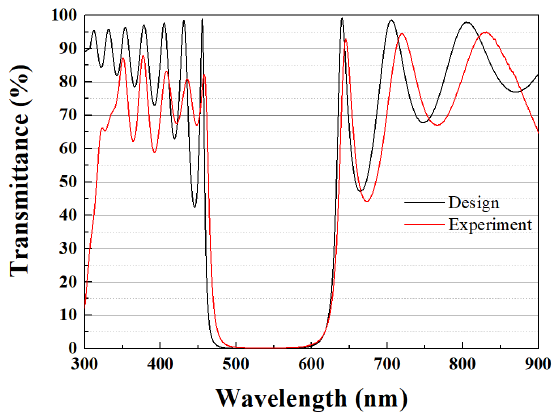
Figure 2. Transmittance spectra of notch filter.